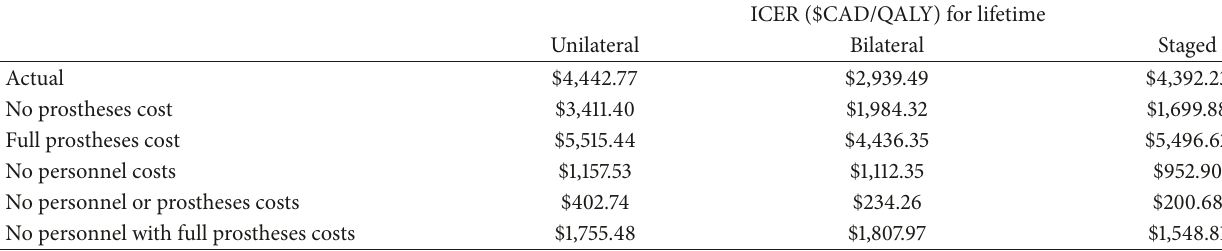
Table 4: Sensitivity analysis for cost of prostheses and of personnel travel and